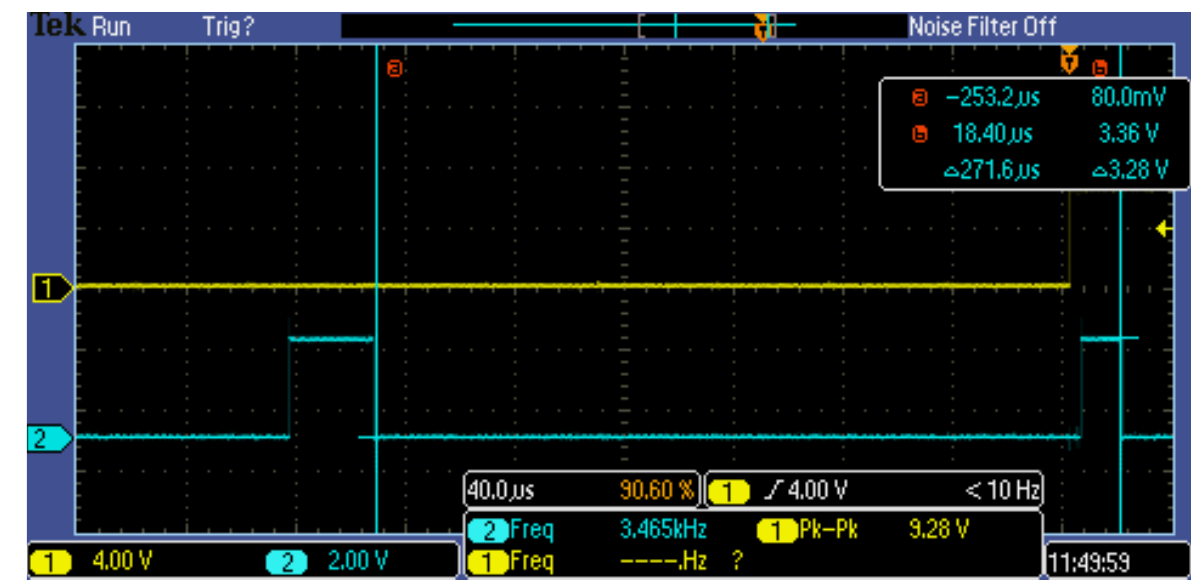
Figure 23. Oscilloscope capture of 3.2 kHz falling edge pulse timing at PPS signal.